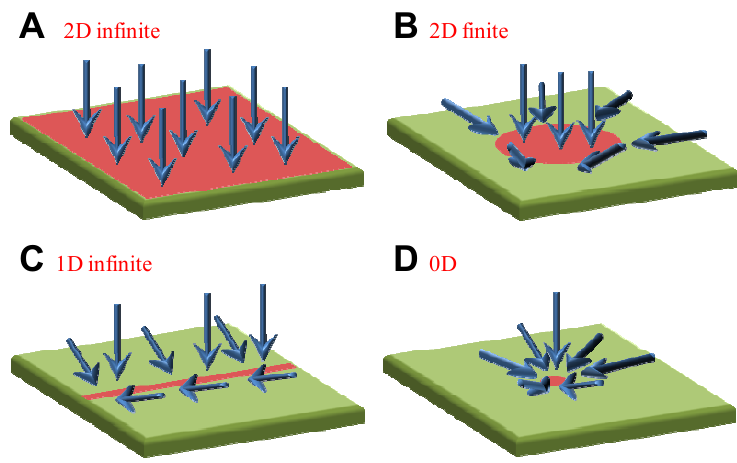
Figure 2. Influence from sensor size on incident flux in a system with diffusion limited binding from stagnant liquids. The arrows show the directions of the analyte flux, assuming that nothing binds outside the active sensor region. The planar infinite surface in ( A ) gives the lowest average incident flux. If the spot is smaller, as in ( B ), the binding rate will become higher, especially at the edges. The binding rate is also higher in ( C ), showing a one dimensional sensor, which gives an incident flux with cylindrical symmetry. The highest average flux to the active area occurs for radial symmetry and a point-like sensor, as shown in ( D